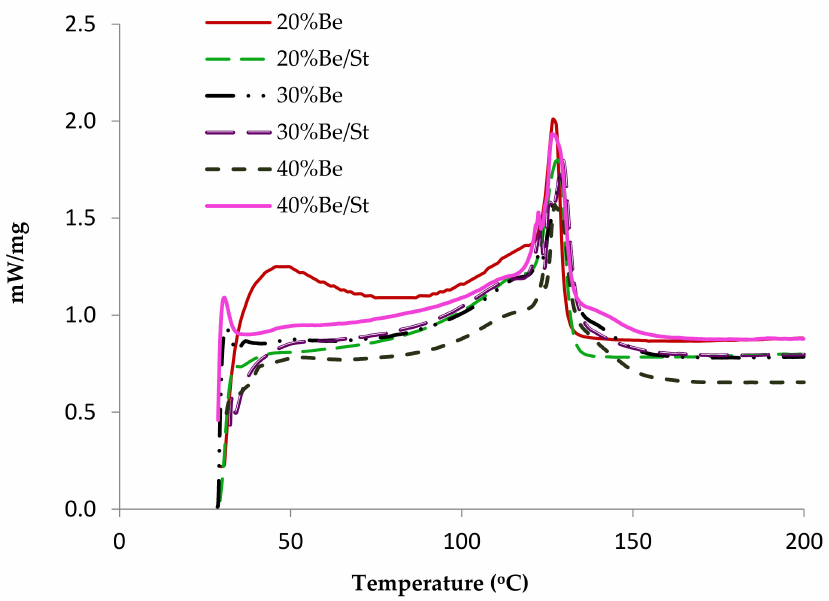
Figure 4. The DSC curve of the bentonite/PE masterbatches.